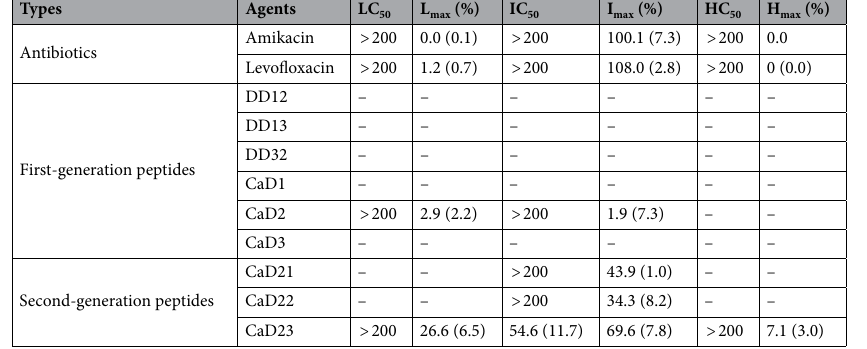
Table 3. Summary of the cytotoxicity, cell viability and hemolytic results of antibiotics and synthetic peptides (in µg/ml concentration). The cytotoxicity and cell viability results were obtained after 3 h of treatment whereas hemolytic effect of treatment was examined after 1 h of treatment. Results are presented in mean (SD) of two independent experiments performed in biological duplicate. Toxicity results of some peptides were missing because their antimicrobial efficacy was poor and hence toxicity was not determined. LC 50: concentration of treatment causing 50% cytotoxicity; L max (%): percentage of cytotoxicity at 200 µg/ml treatment concentration; IC 50 : concentration of treatment causing 50% inhibition of cell viability; I max (%): percentage of inhibition of cell viability at 200 µg/ml treatment concentration; HC 50 : concentration of treatment causing 50% hemolysis; H max (%): percentage of hemolysis at 200 µg/ml treatment concentration.